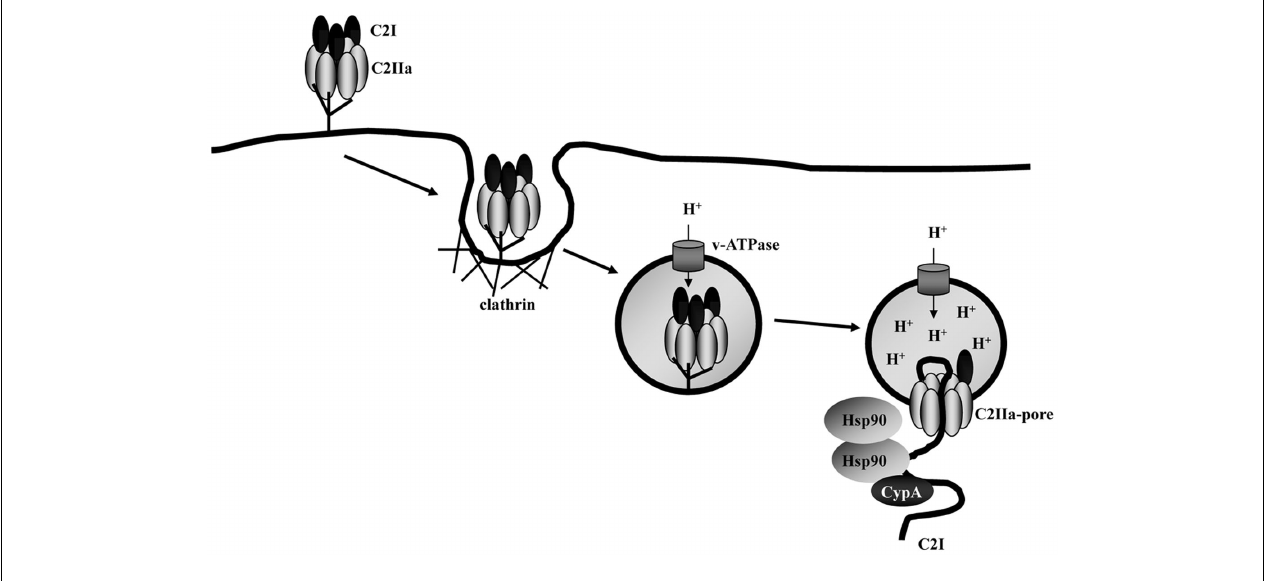
membrane insertion and pore formation by C2IIa. C2I translocates in an unfolded conformation through the C2IIa pores across endosomal membranes into the cytosol. Hsp90 and cyclophilin A (CypA) facilitate